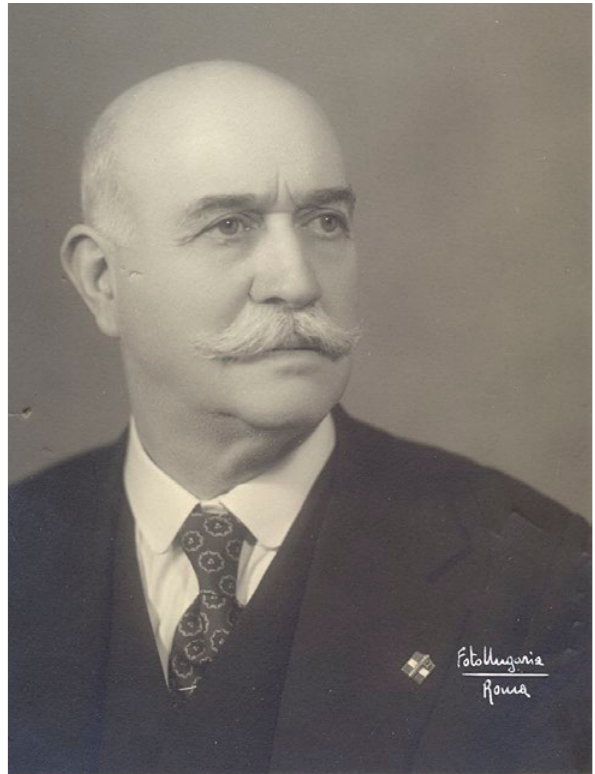
Figure 2. Mario Betti (Courtesy of dr. Massimo